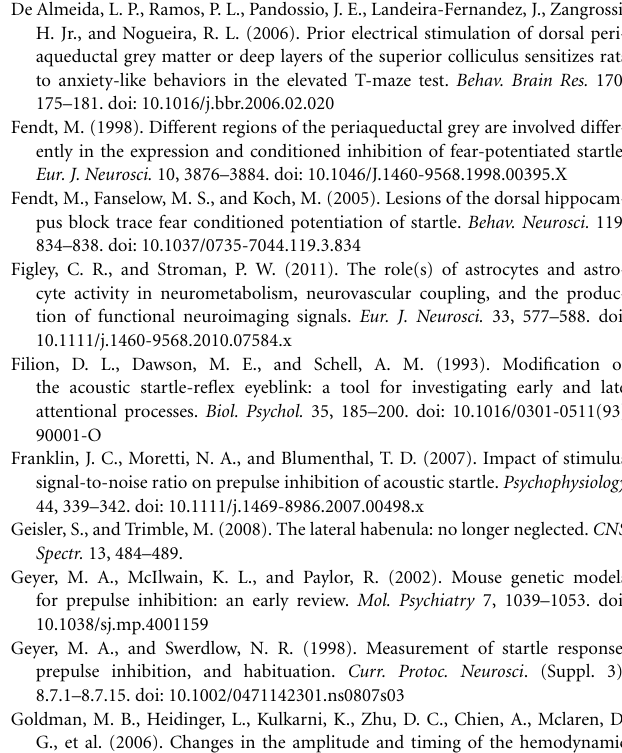
Figley, C. R., and Stroman, P. W. (2011). The role(s) of astrocytes and astro- cyte activity in neurometabolism, neurovascular coupling, and the